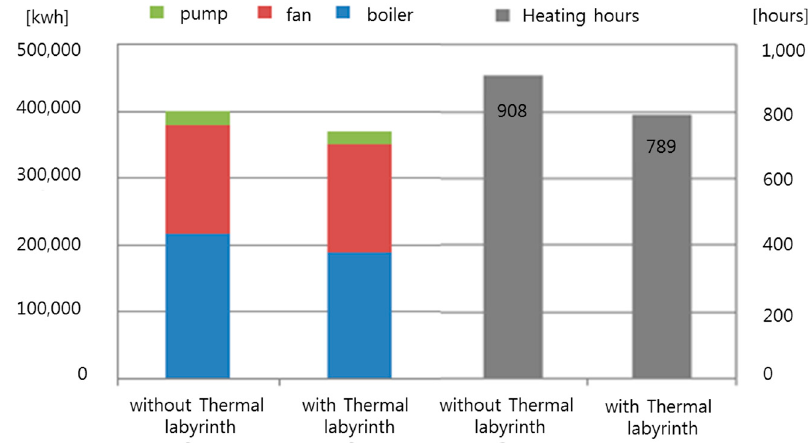
Figure 16. Heating energy consumption and heating hours.